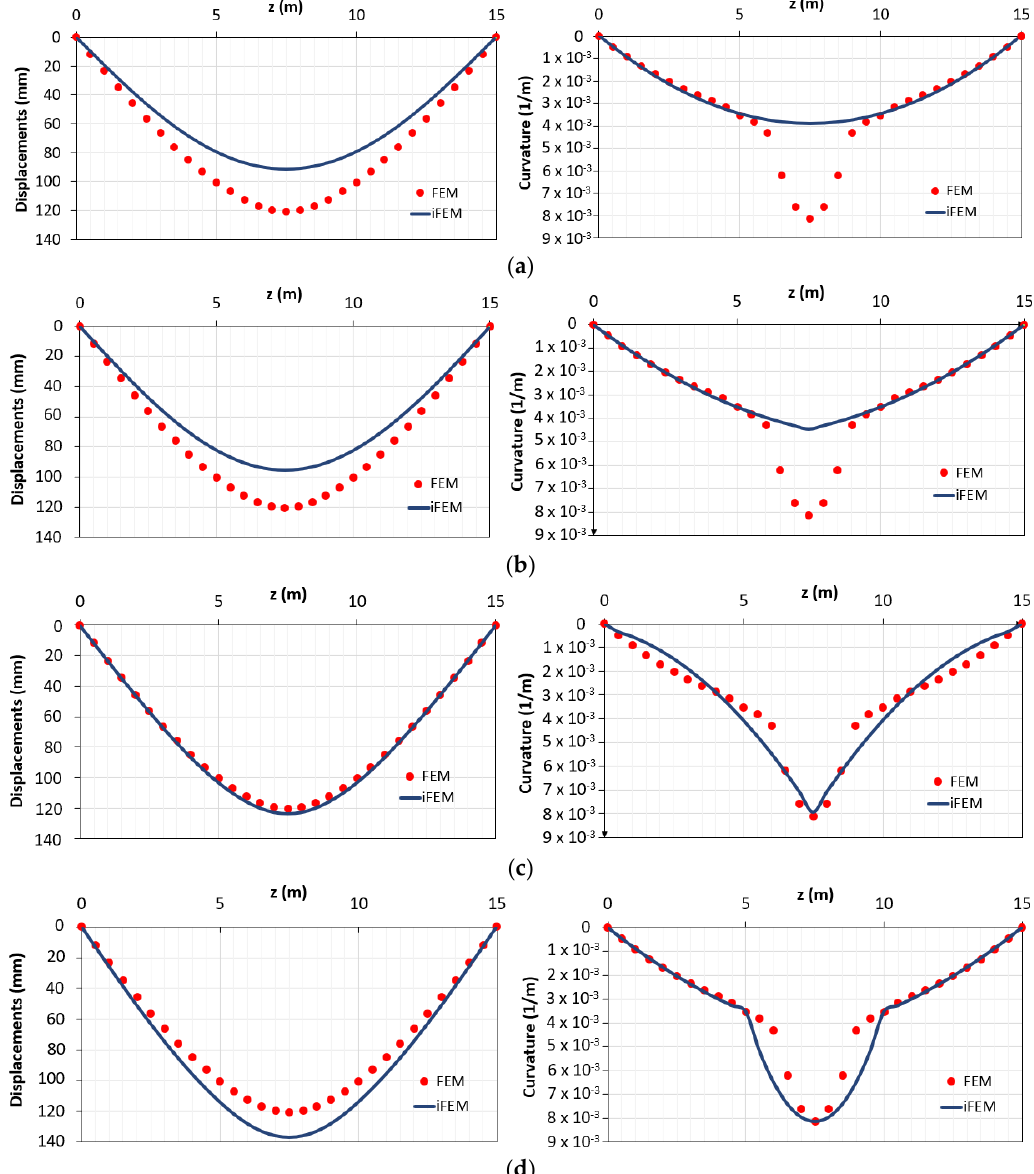
Figure 8. Displacements and curvatures diagrams for: ( a ) configuration “a”; ( b ) configuration “b”; ( c ) configuration “c”; ( d ) configuration “d”.